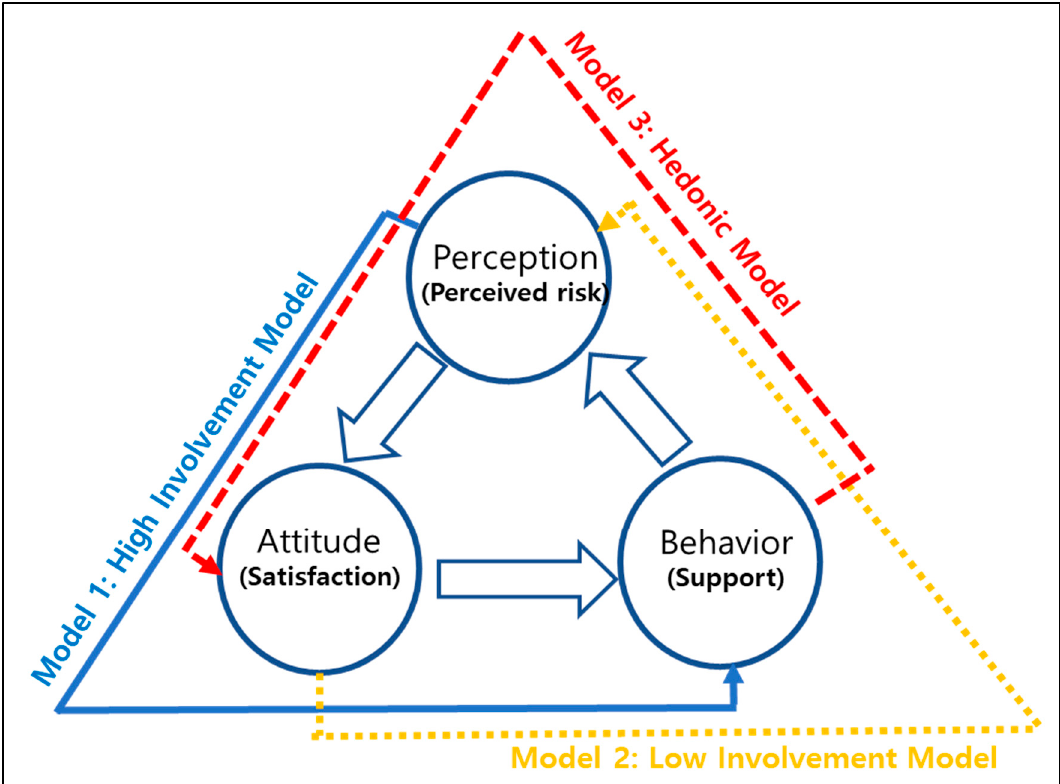
Figure 1. Conceptual framework.